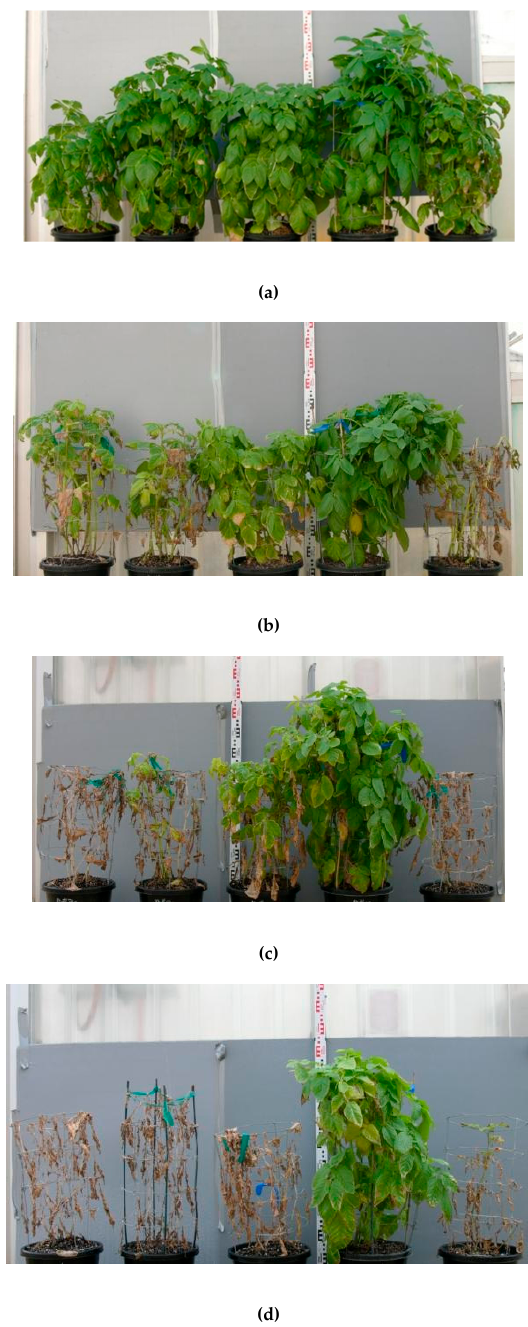
Figure 3. The effect of treatment on canopy appearance on the day before harvest at 65 ( a ); 81 ( b ); 92 ( c ) and 103 ( d ) days after planting. Treatments, from left to right, SALT + 7.5%F, SALT + 15%F, SALT + 22.5%F, CONT, 85% SALT. On the survey rod in the background, the distance between base of the E shape and the base of its adjacent mirror image is 10